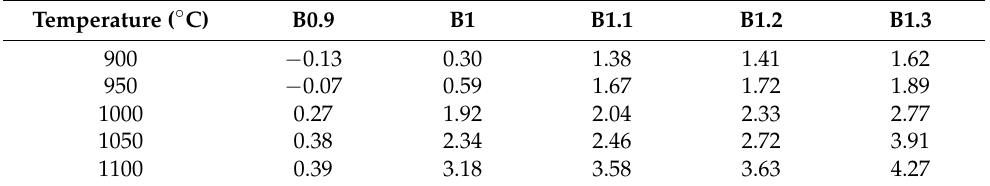
Table 3. LS of the samples with different formulations treated at 900~1100 ◦ C for 3